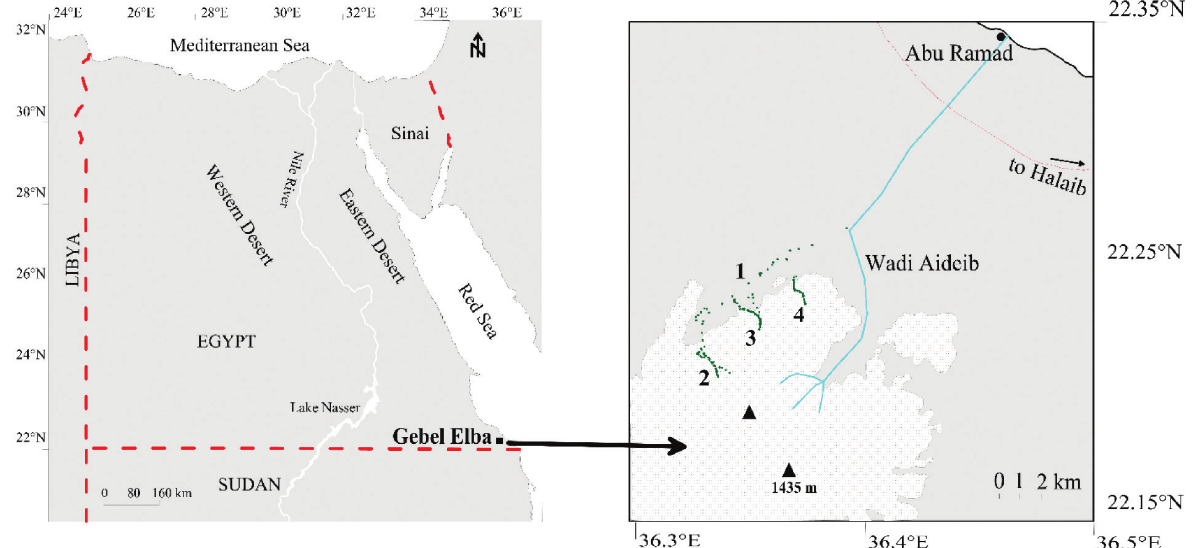
Figure 1. The location of Gebel Elba in Egypt (left) and the distribution of the vegetation relevés (green dots) sur- veyed for this study in Wadi Yahmib and its tributaries at the northern slopes of Gebel Elba (right); Wadi Yahmib (1), Wadi Marafai (2), Wadi Acow (3) and Wadi Kansisrob